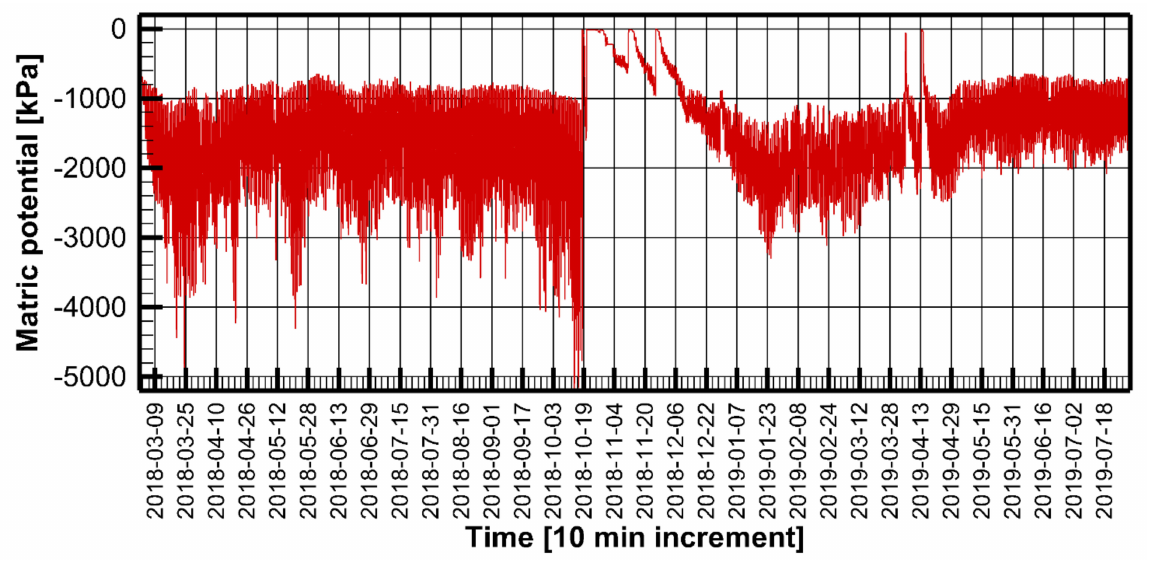
Figure 11. Soil matric potential from the shallow probes of lysimeter 1 and 2.